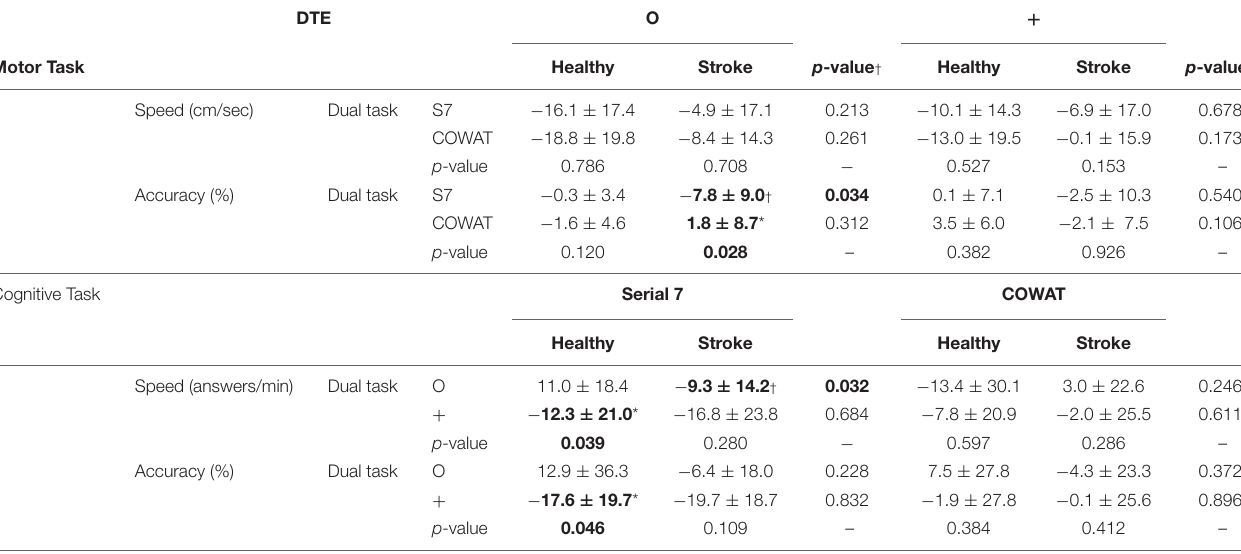
Frontiers in Human Neuroscience | www.frontiersin.org